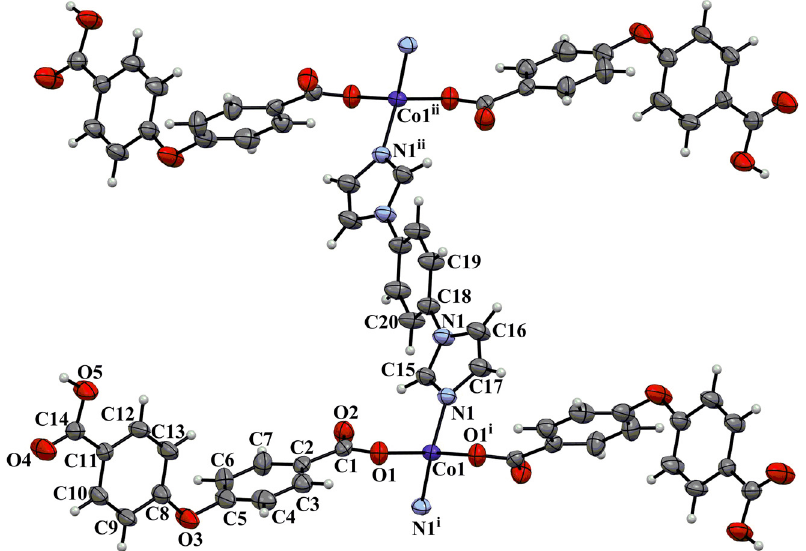
Table  : Data collection and